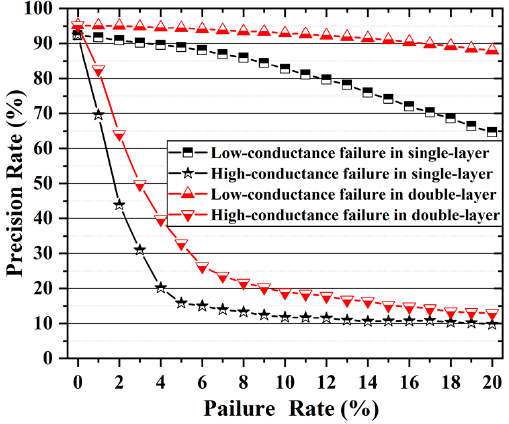
Figure 7. The network image recognition accuracy rate varies with the proportion of failed devices.